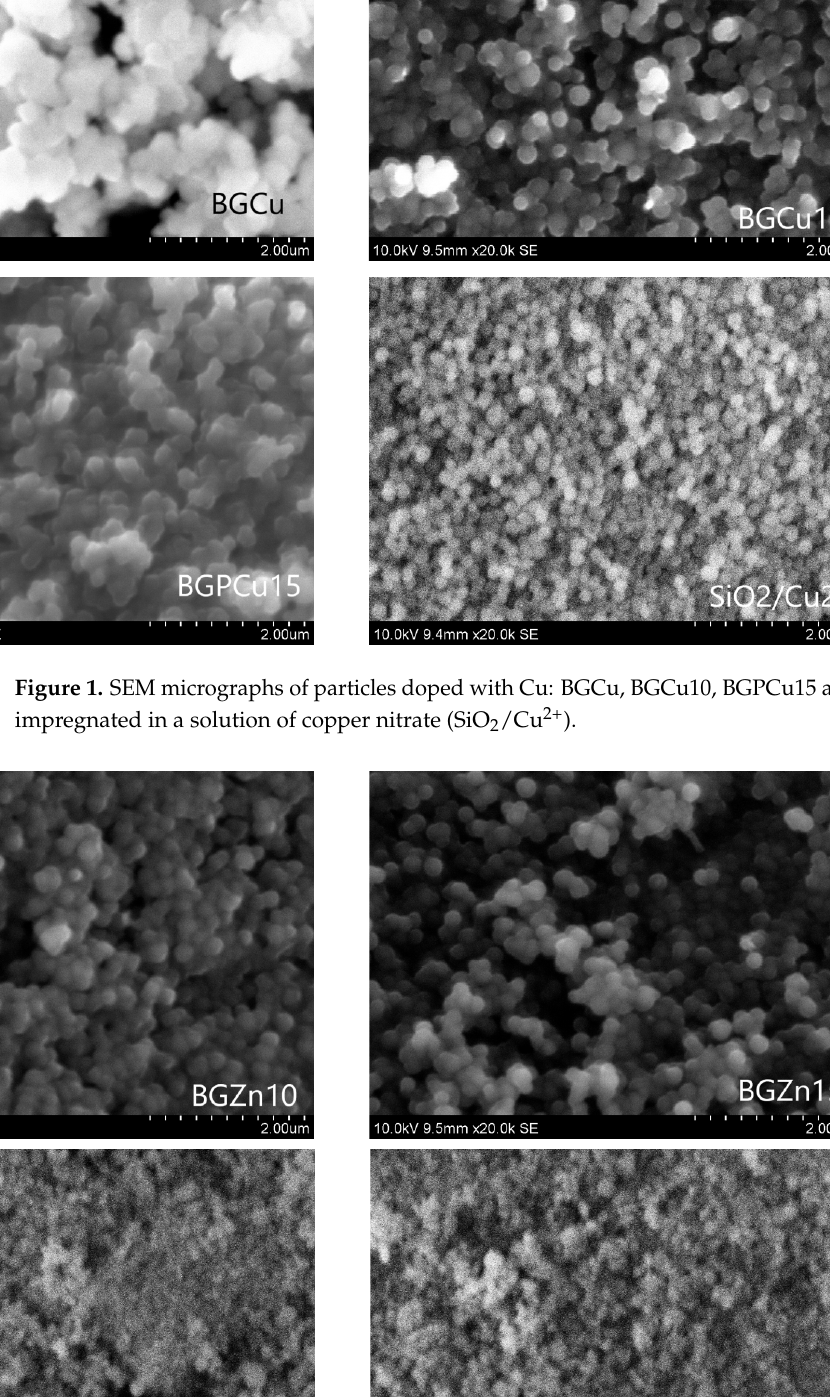
Figure 2. SEM micrographs of particles doped with Zn: BGZn10, BGZn15, BGPZn15 and BGPZn10. Table 4 . EDX analysis of the samples with Zn.